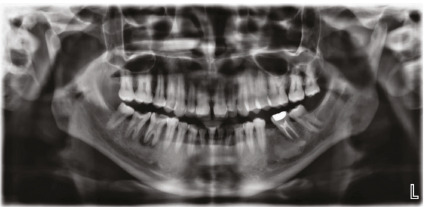
Figure 6: Case 1: dental panoramic tomography (DPT) shows taurodontism in